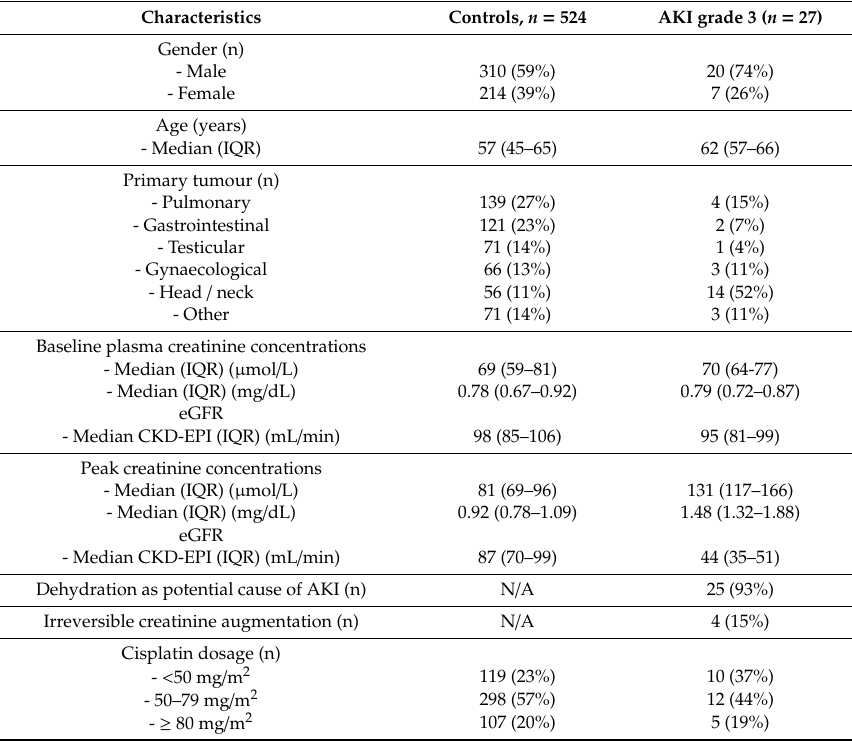
Table 3. Patient characteristics.